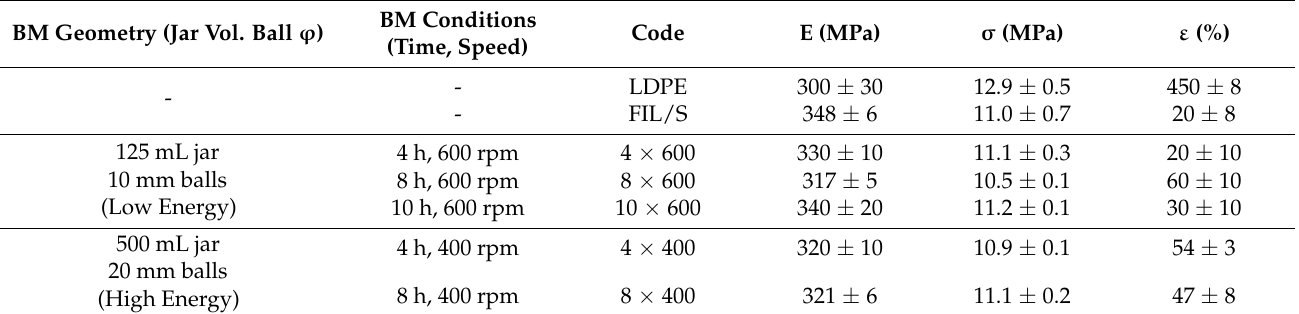
Table 1. Codes, BM conditions and mechanical parameters of the recycled